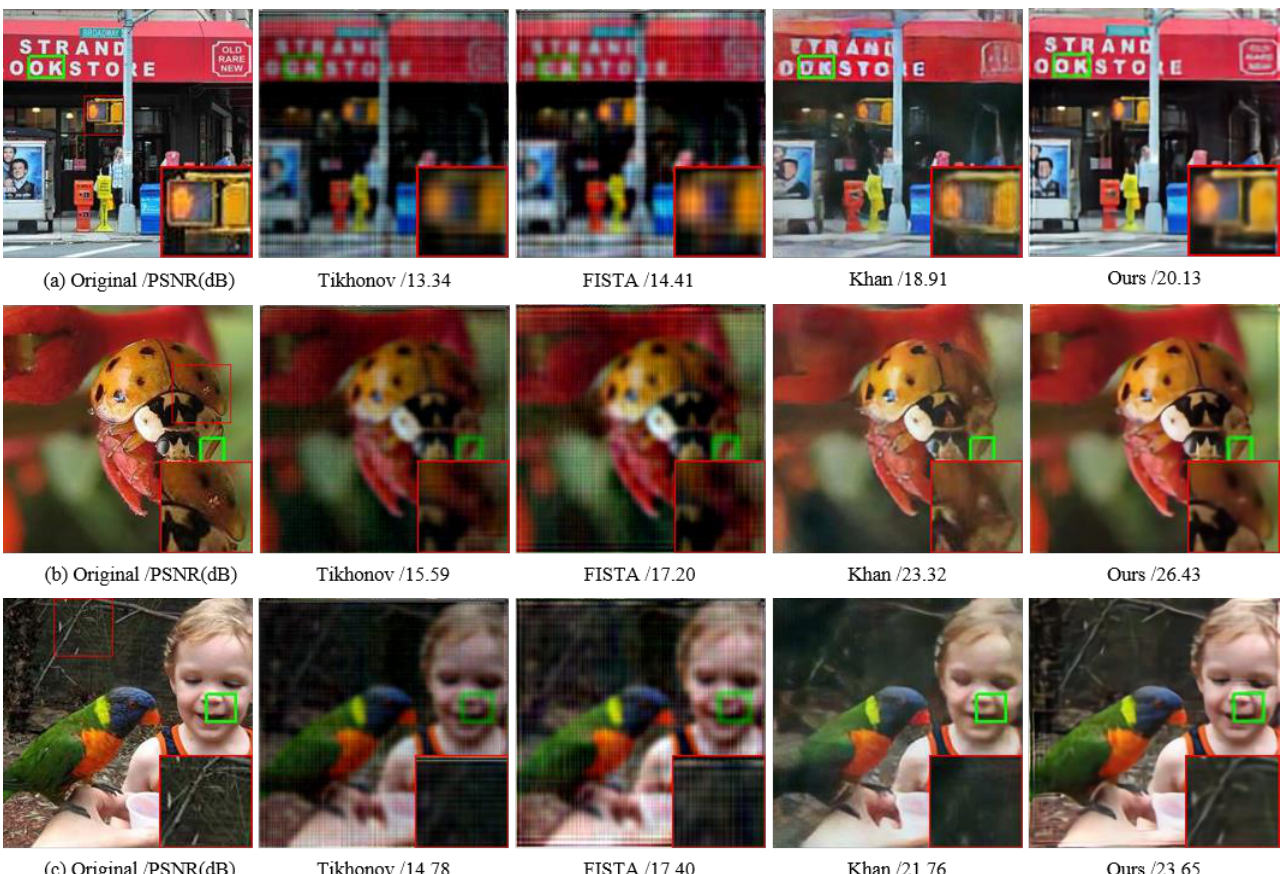
Table 7. The average PSNR and SSIM values of 100 images in DIV2K’s valid set